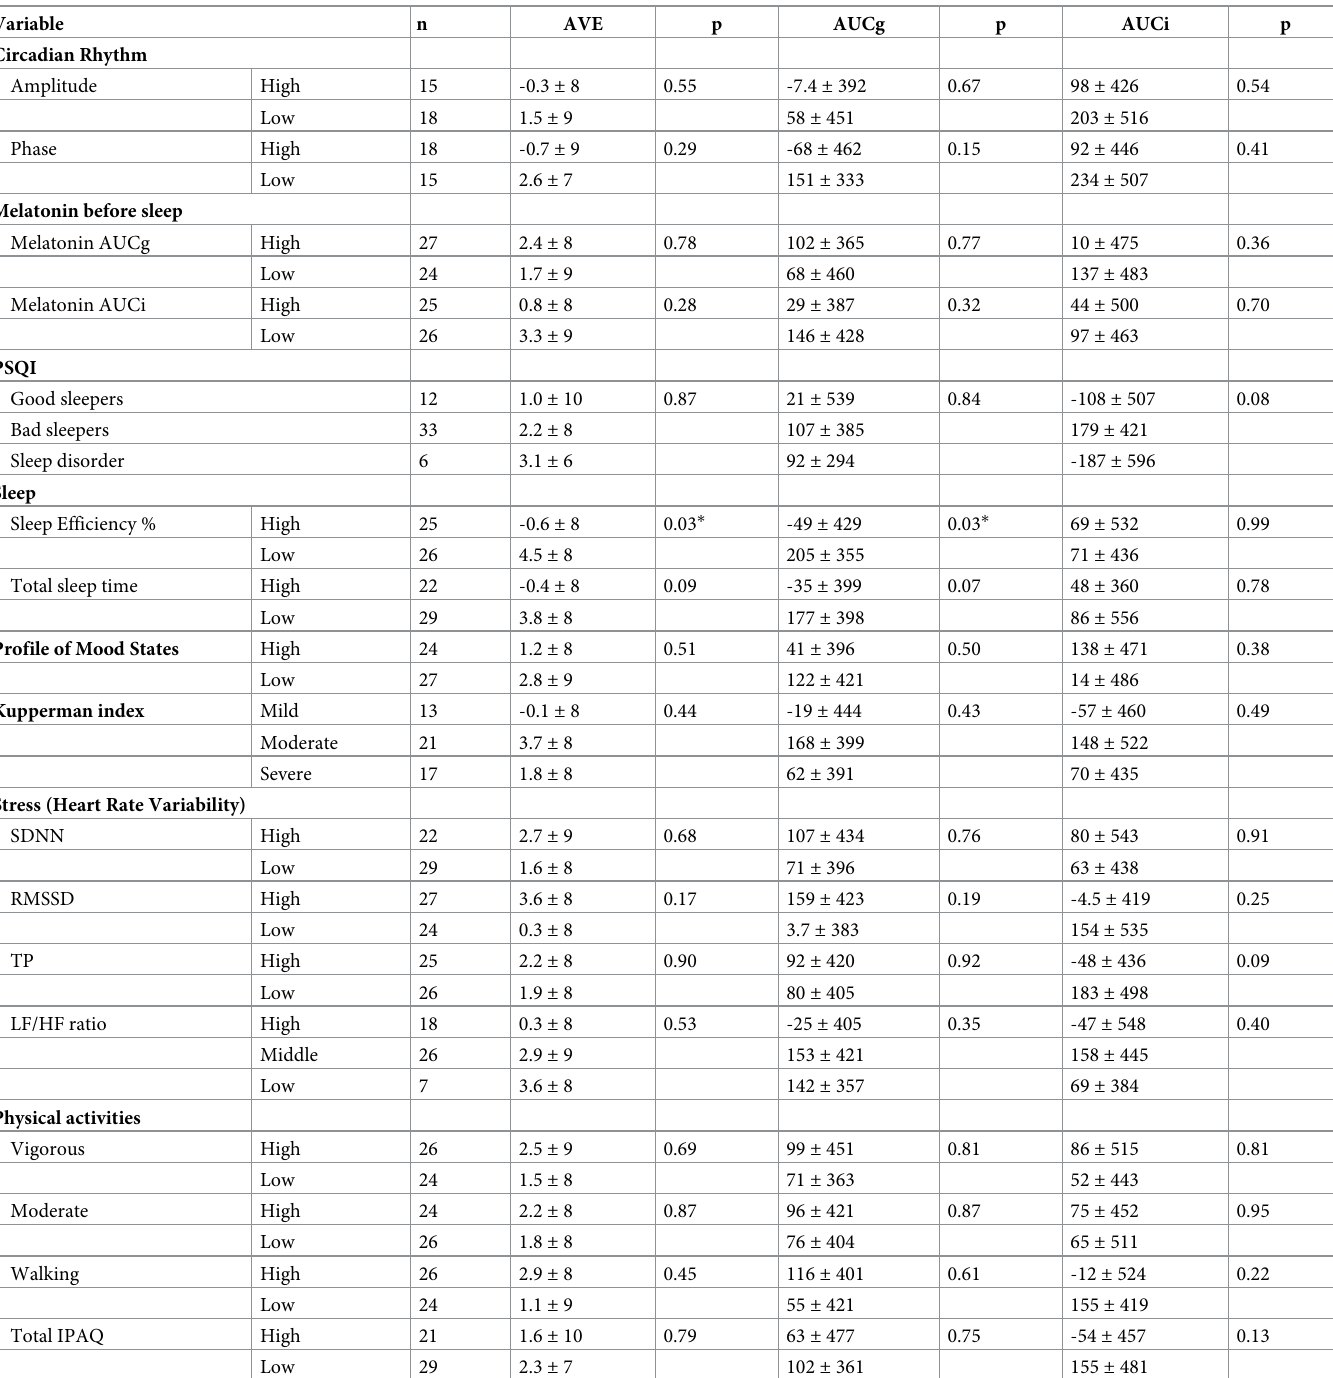
Table 6. Differences in the changes of CAR based on multiple variables including circadian rhythms, sleep, stress, and physical activities.